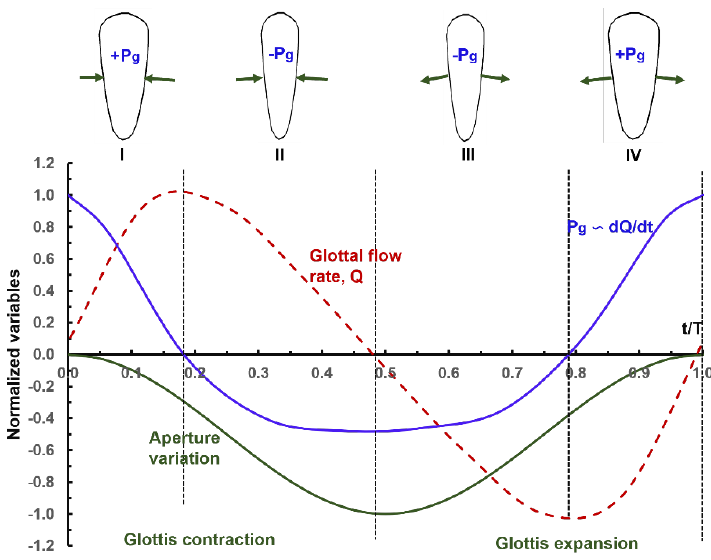
Figure 15. Responses of the glottal flow rate and intra-glottal pressure (P g ) to one cycle of the glottal vibration at f 0 = 200 Hz.